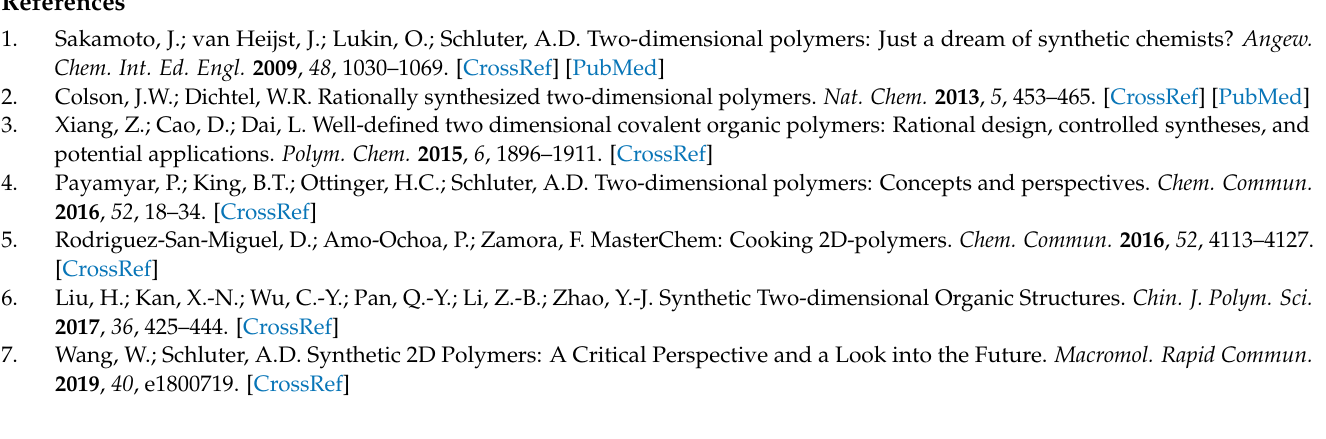
M1 ; Figure S1: Surface pressure-mean molecular area (SP-MMA) isotherm of compressing M1 at a compression rate of 3 mm/min; Figure S2: BAM images of the process of compressing M1 in the SP-MMA isotherm study; Figure S3. Free-standing P1 film on a copper TEM grid. Figure S4: Raman spectrum of the depolymerization process of P1 . Figure S5: (a) XPS survey spectra of P1 and (b) XPS C 1s spectra of P1 on SiO 2 /Si wafer. Figure S6: Mass spectrum of the compound D1 ; Figure S7: Mass spectrum of the compound M1 ; Figure S8: 1 H NMR spectrum of compound (1 ); Figure S9: 1 H NMR spectrum of compound (2 ); Figure S10: 1 H NMR spectrum of the compound R1 ; Figure S11: 13 C NMR spectrum of the compound R1 ; Figure S12: 19 F NMR spectrum of the compound R1 ; Figure S13: 1 H NMR spectrum of the compound D1 ; Figure S14: 13 C NMR spectrum of the compound D1 ; Figure S15: 19 F NMR spectrum of the compound R1 ; Figure S16: 1 H NMR spectrum of the compound M1 ; Figure S17: 13 C NMR spectrum of the compound M1 ; Figure S18: 19 F NMR spectrum of the compound M1 ; Table S1: The single crystal date of R1